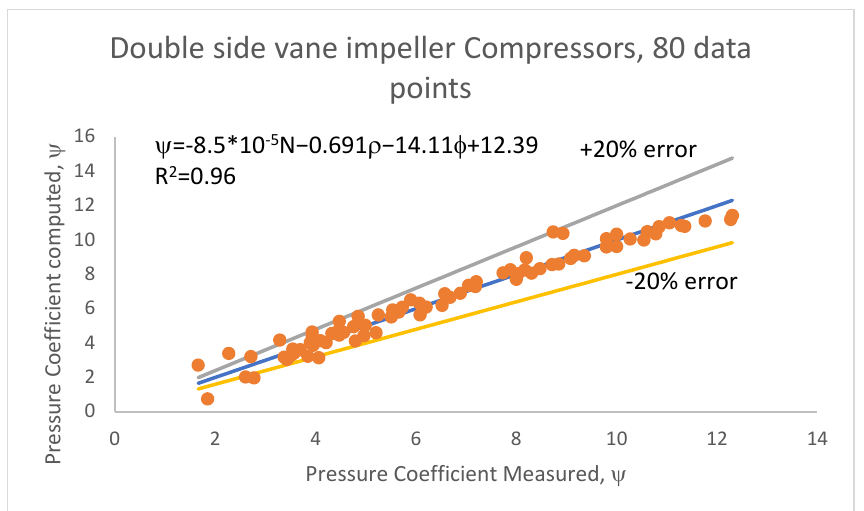
Figure 6. Pressure coefficient of double-side vane impeller compressor as computed by the correlation obtained from the data of Badami and Mura [14].